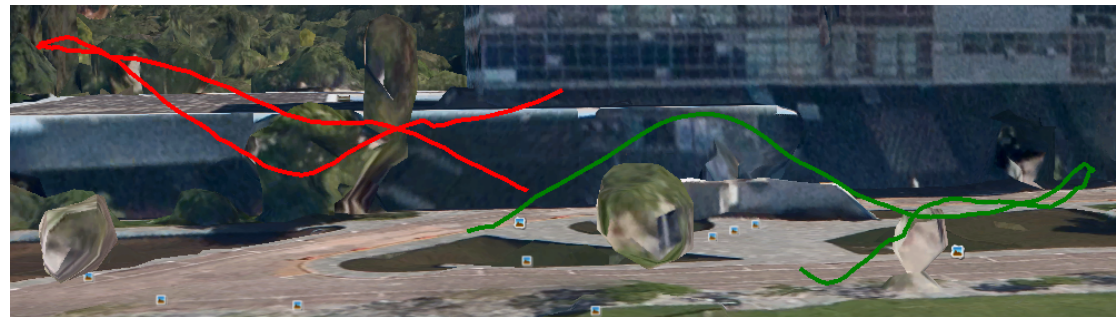
Figure 15. Selected sequences of the manual flights for clear visualization.